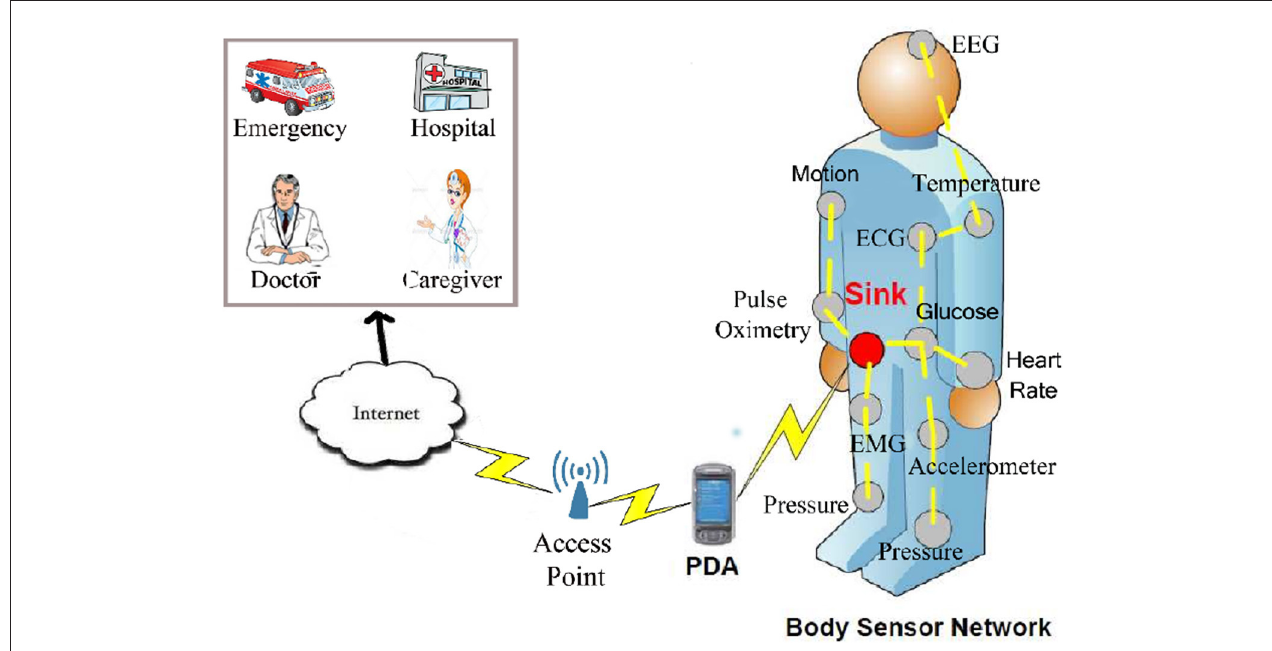
FIGURE 1 | Wireless body network and its applications